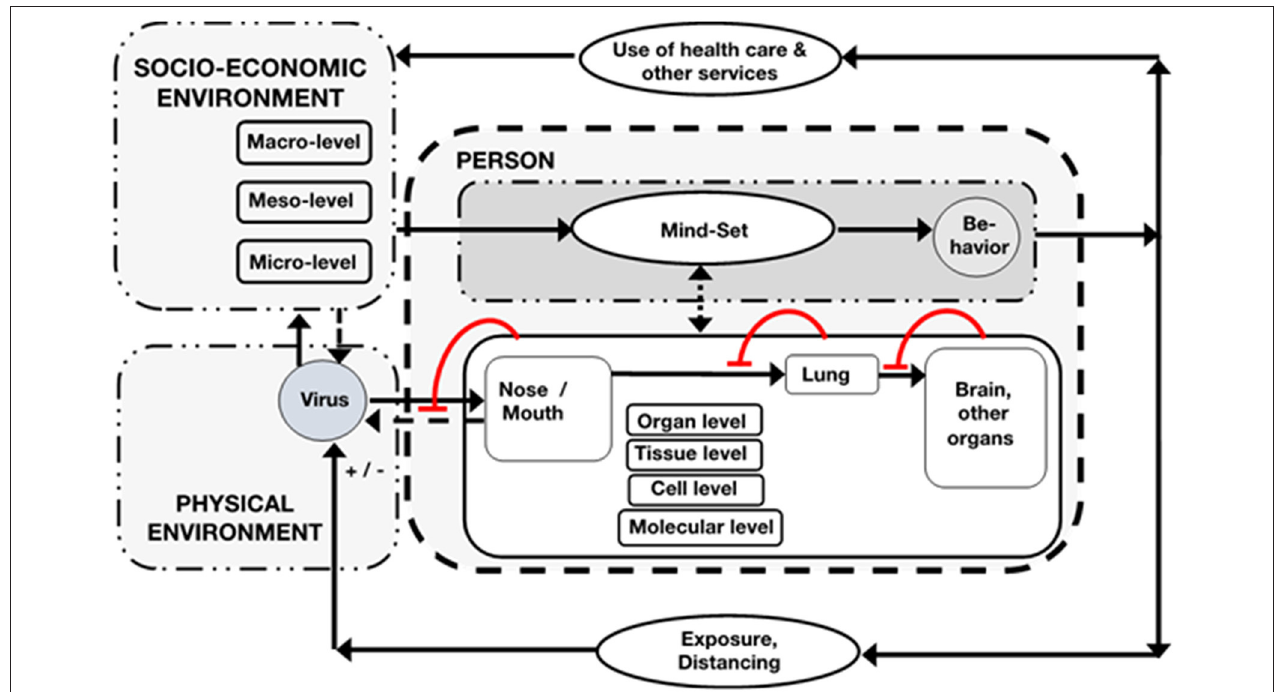
FIGURE 1 | Systemic compartment model of the individual person with its respiratory system that primarily is confronted with and affected by SARS-CoV-2, that invades cells within tissues of respiratory (and others) organs of the organism, step by step. But invasion can be attenuated by local defense mechanisms (circular lines with transoms). Spreading of the virus can occur (stippled arrow). The person can experience the sickness by symptoms (stippled double arrow) and/or obtains and utilizes the information provided by the respective socio-economic system on micro-, meso-, and macro-level and its knowledge about the virus and its prevention and treatment. With this mindset, depending on social context, the person might change behavior by reduction of the exposure (–) by lockdown, distancing, quarantine etc. or will exert risky behavior ( + ) with respective consequences for the social environment. A major feedback loop is also organization of health care and other services (6, 7) as well as access to these health care services which is not equally distributed in the society (5,